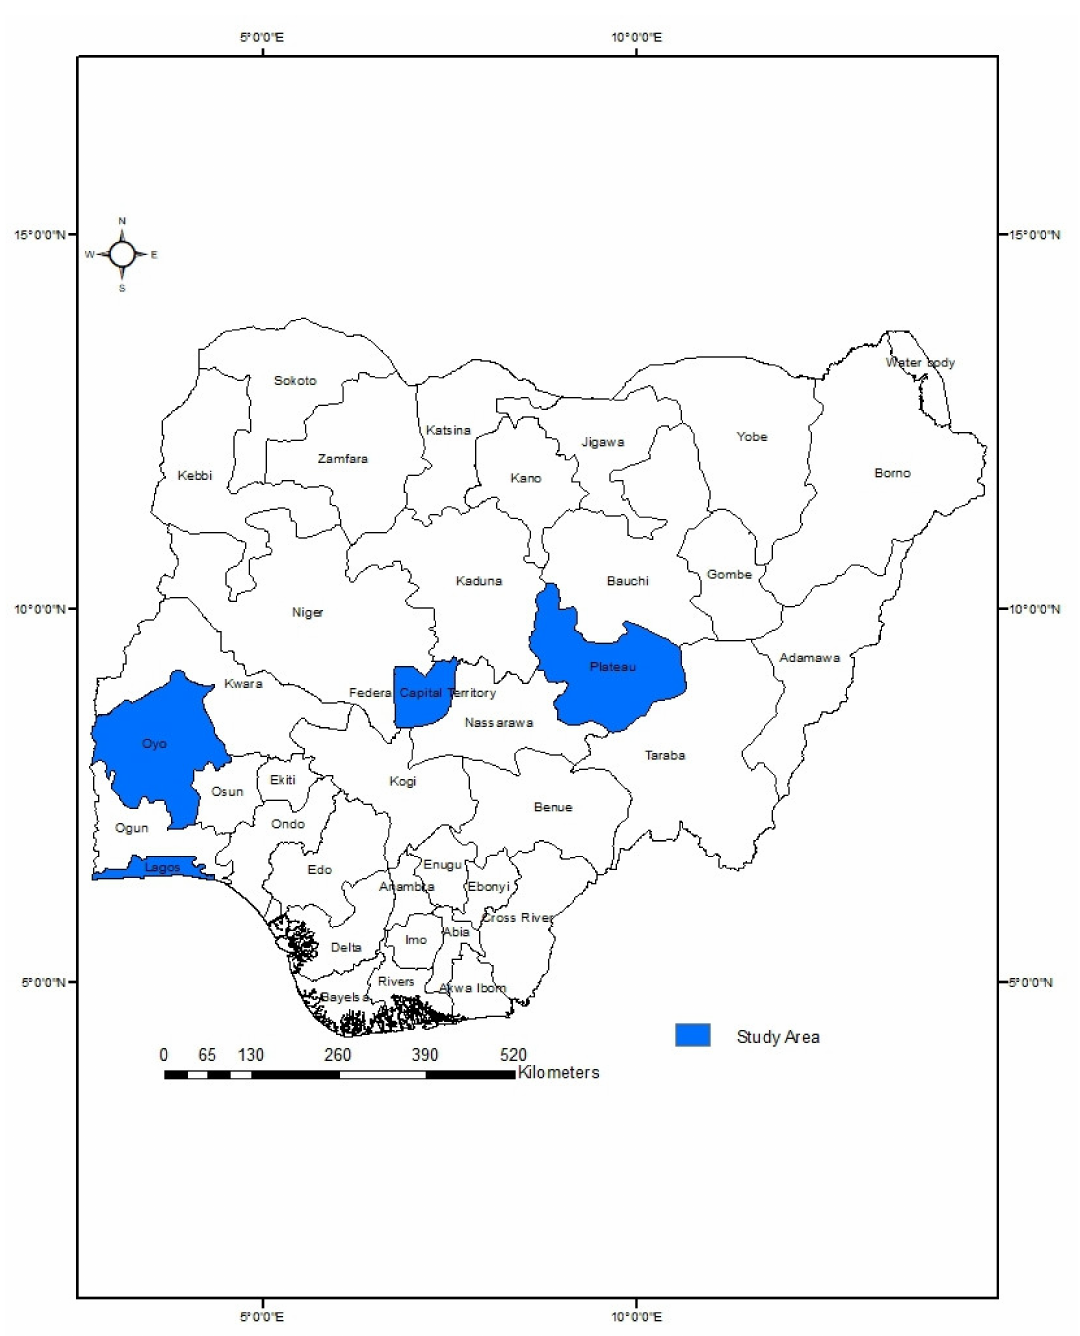
Figure 1. Map of Nigeria showing the study